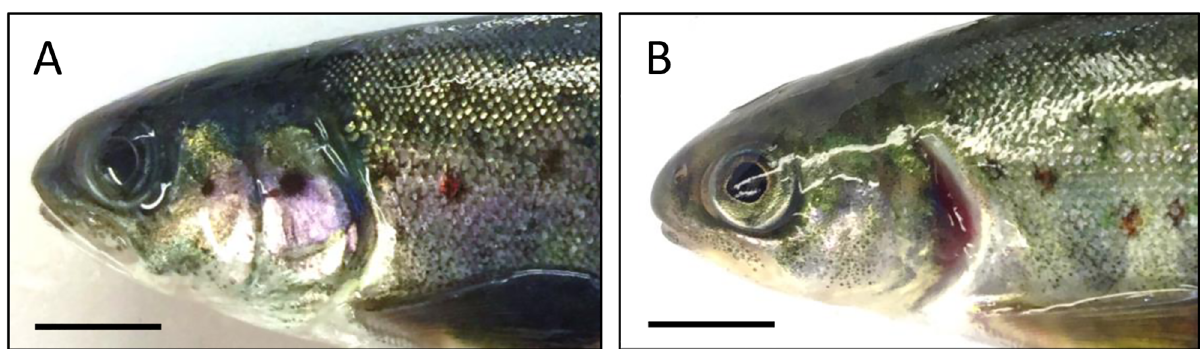
Fig 2. Lateral view of the head region of fish at parr stage. View of anterior (cranial-trunk) of fish at parr stage (1390 ddPSF). (A) normal operculum and (B) moderate opercular shortening. Scale bars represent 1cm.